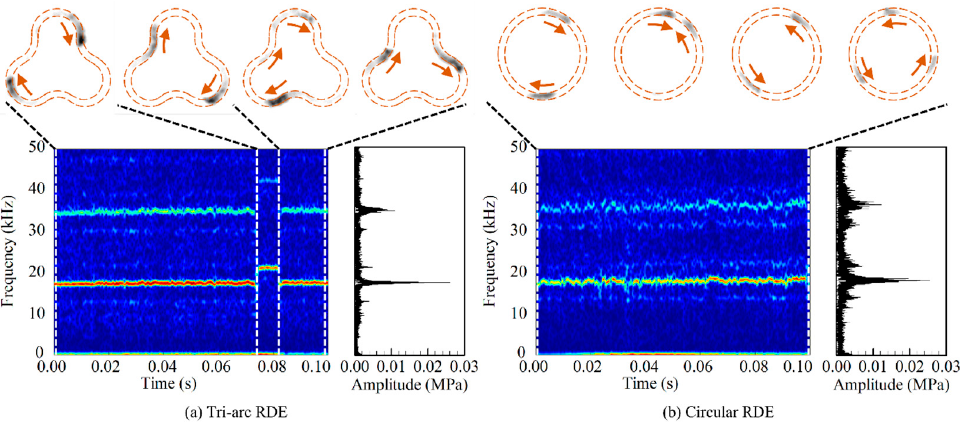
Figure 10. Experimental visualization ( upper ), STFT ( lower-left ), and FFT ( lower-right ) results at high mass flow rate, 𝑚(cid:4662) = 130.7 ± 0.71 g/s for Φ = 1.042 ± 0.0013 ; tri-arc ( a ) and circular ( b ) RDEs